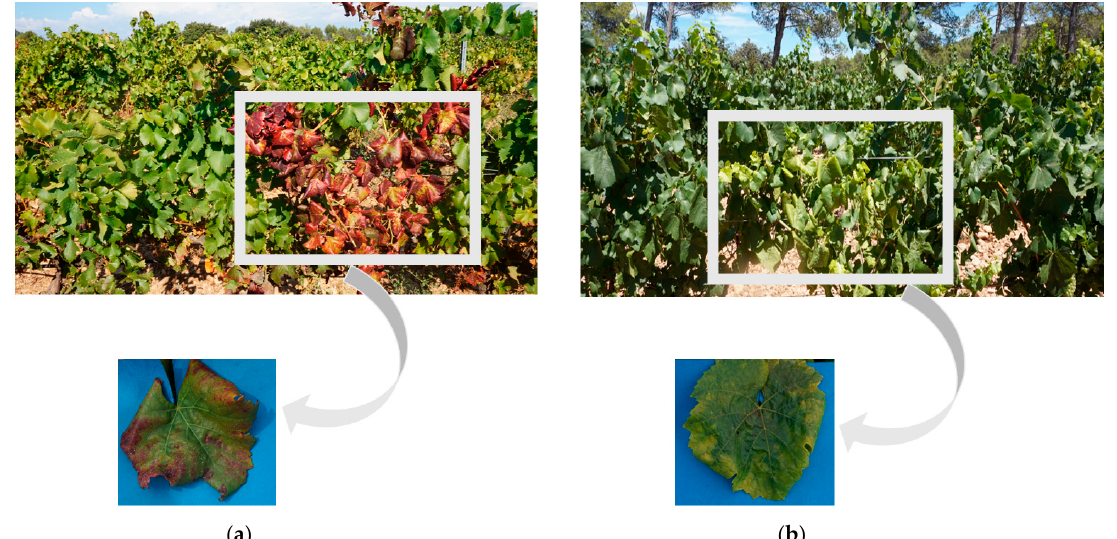
Figure 1. Some symptoms of FD on leaves: a red discoloration on a red grapevine variety ( a ) and a yellow discoloration on a white grapevine variety ( b ); windings of leaves can also be noticed.